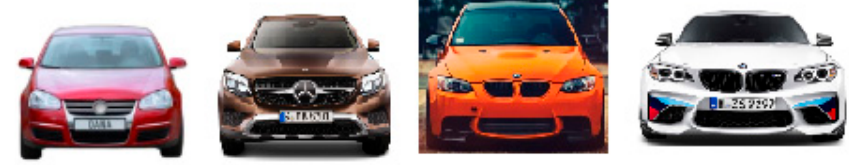
Figure 8. Samples of front views added in the positive dataset.